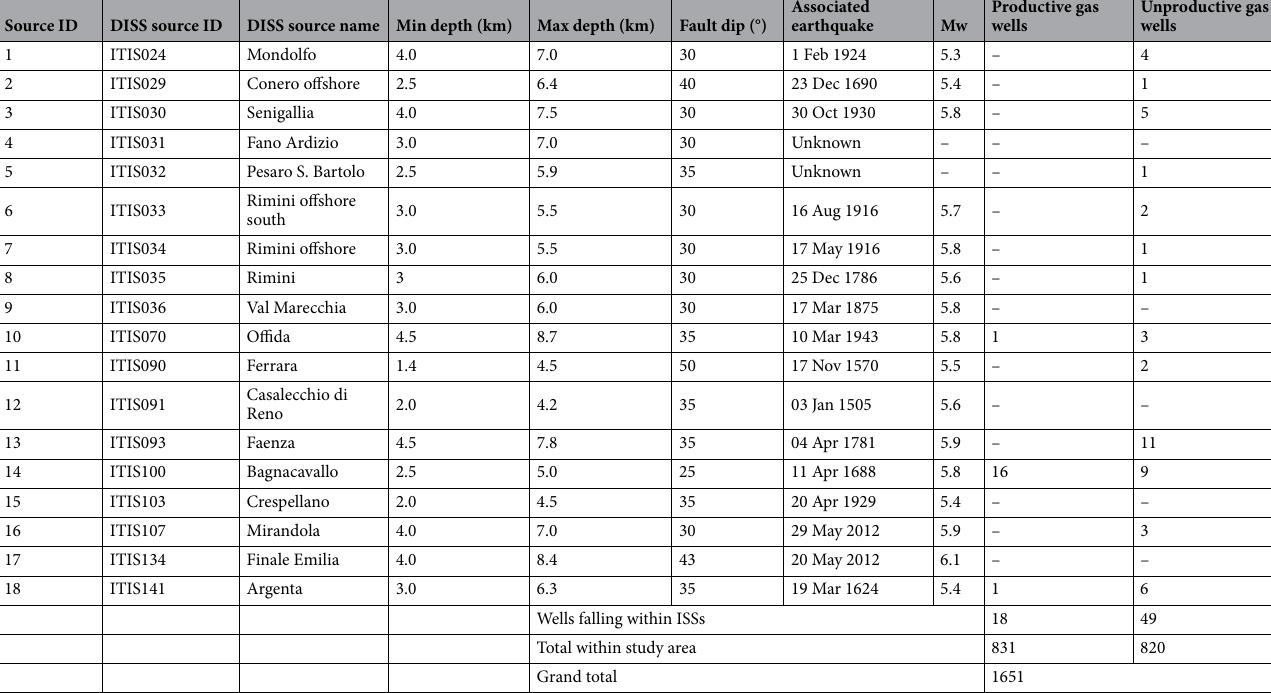
Table 1. Main parameters of Individual Seismogenic Sources falling within our study area. Summary of the seismogenic faults occurring in the study area, showing also the number of wells falling within the surface projection of each source (see the “Methods” section). All earthquake magnitudes (M w ) are from the CFTI5Med catalogue (http:// stori ng. ingv. it/ cfti/ cfti5/), except for the 20 and 29 May 2012 events, whose magnitude is from the CPTI15 catalogue (https:// emidi us. mi. ingv. it/ CPTI15-